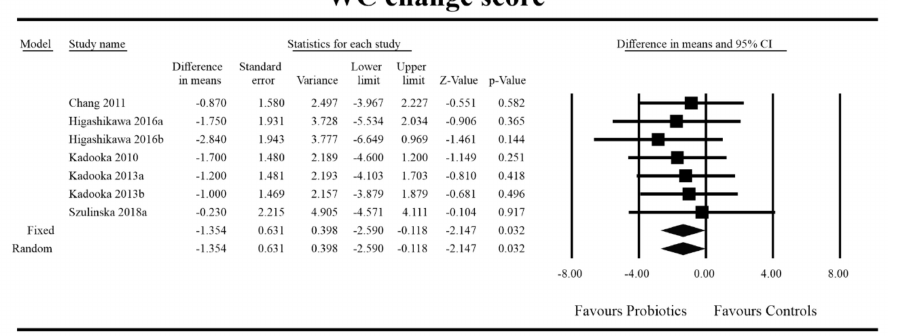
Figure 7. EffectsizeanddifferenceinmeansforWCinpersonstakingprobioticsvs. controls(changescores). Q = 1.102, df (Q) = 6 p = 0.981, I-squared = 0.0. WC—waist circumference.